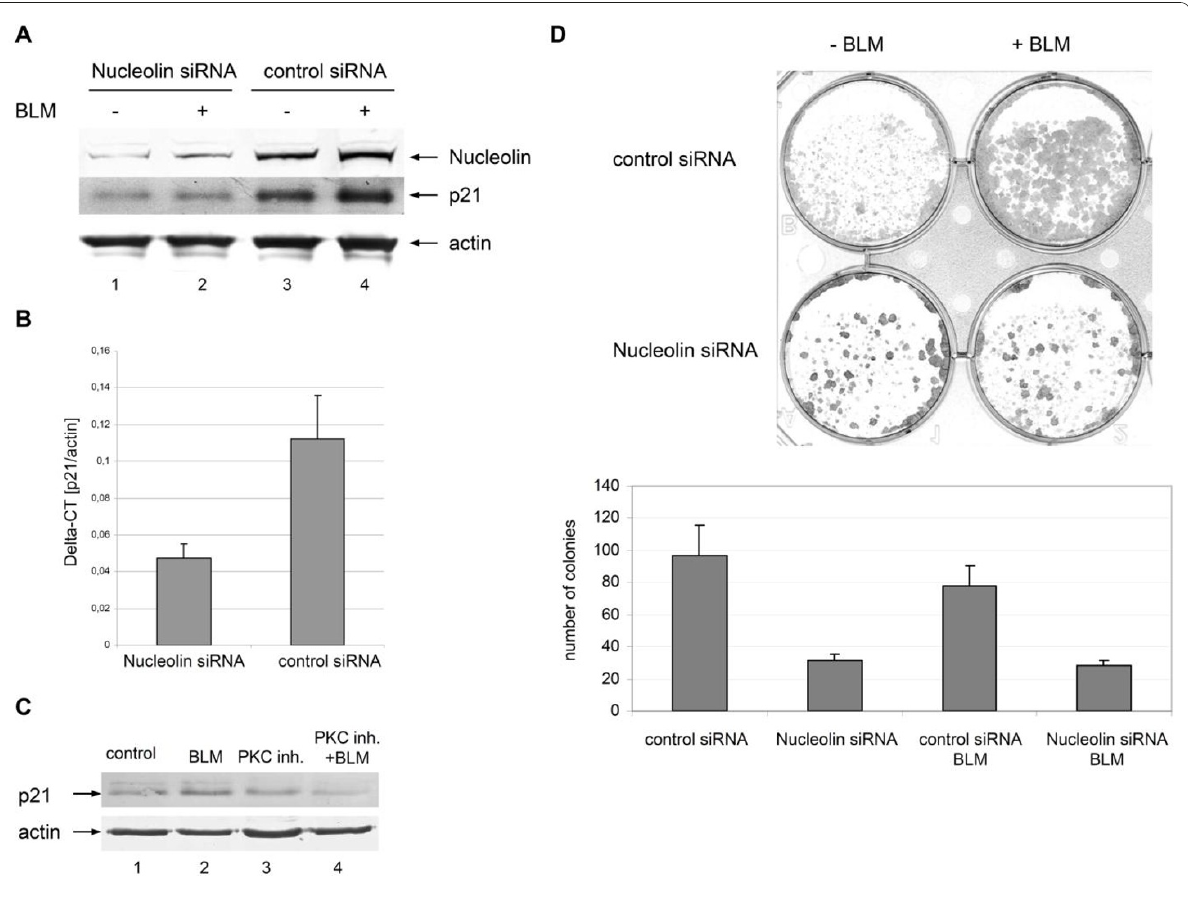
Figure 5 Depletion of nucleolin induced downregulation of p21 and impeded cell proliferation . (A) Protein extract of human HaCaT cells transfected with specific nucleolin siRNA (lanes 1-2) or unspecific control siRNA (lanes 3-4) which were treated with BLM for 30 min (lanes 2 and 4) or untreated cells (lanes 1 and 3) were subjected to immunoblotting against nucleolin and p21 using specific antibodies. As a control for equal protein loading corresponding actin levels are shown by immunoblot. (B) HaCaT keratinocytes transfected with specific nucleolin siRNA or unspecific control siRNA were cultured for 72 h and treated for 1hour with BLM (12.5 μ g/ml). Then total RNA was extracted from the cells and p21 gene expression analysis was performed. The CT values of p21 were normalized to actin. Two independent experiments were performed and data are displayed as mean values (±SD). (C) HaCaT cells treated with BLM, the myristoylated PKC inhibitor, or both BLM and PKC inhibitor, and, as a control, untreated cells were lysed and protein extracts were subjected to immunoblotting using a specific antibody against p21. As a control for equal protein loading corresponding actin levels are shown by immunoblot. (D) Decreased proliferation capacity of nucleolin- depleted HaCaT cells. For assessment of the proliferation capacity of HaCaT keratinocytes, colony formation assays were carried out. HaCaT cells were transfected with a specific nucleolin siRNA or, as a control, with unspecific control siRNA, treated with BLM 72 h after transfection and grown for further 7 d (+BLM). As a control, transfected cells grown without BLM treatment (-BLM). For quantification, the colonies in 3 representative areas (1.0 cm diameter) of 6-well dishes with transfected HaCaT cells with (+BLM) or without (-BLM) BLM treatment were counted. Data are displayed as mean values